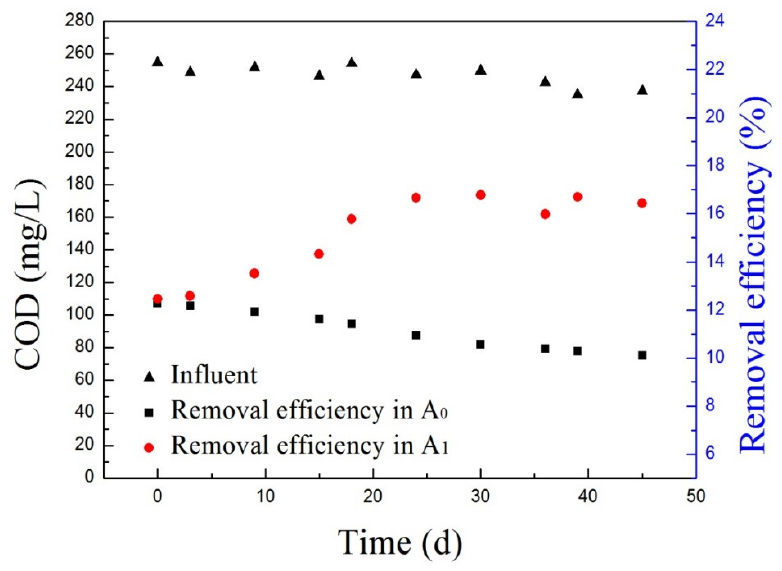
Figure 6. Variations of the COD removal performance and the influent COD values in parallel bioreactors. (A 0 (glucose-free) and A 1 (glucose added)).